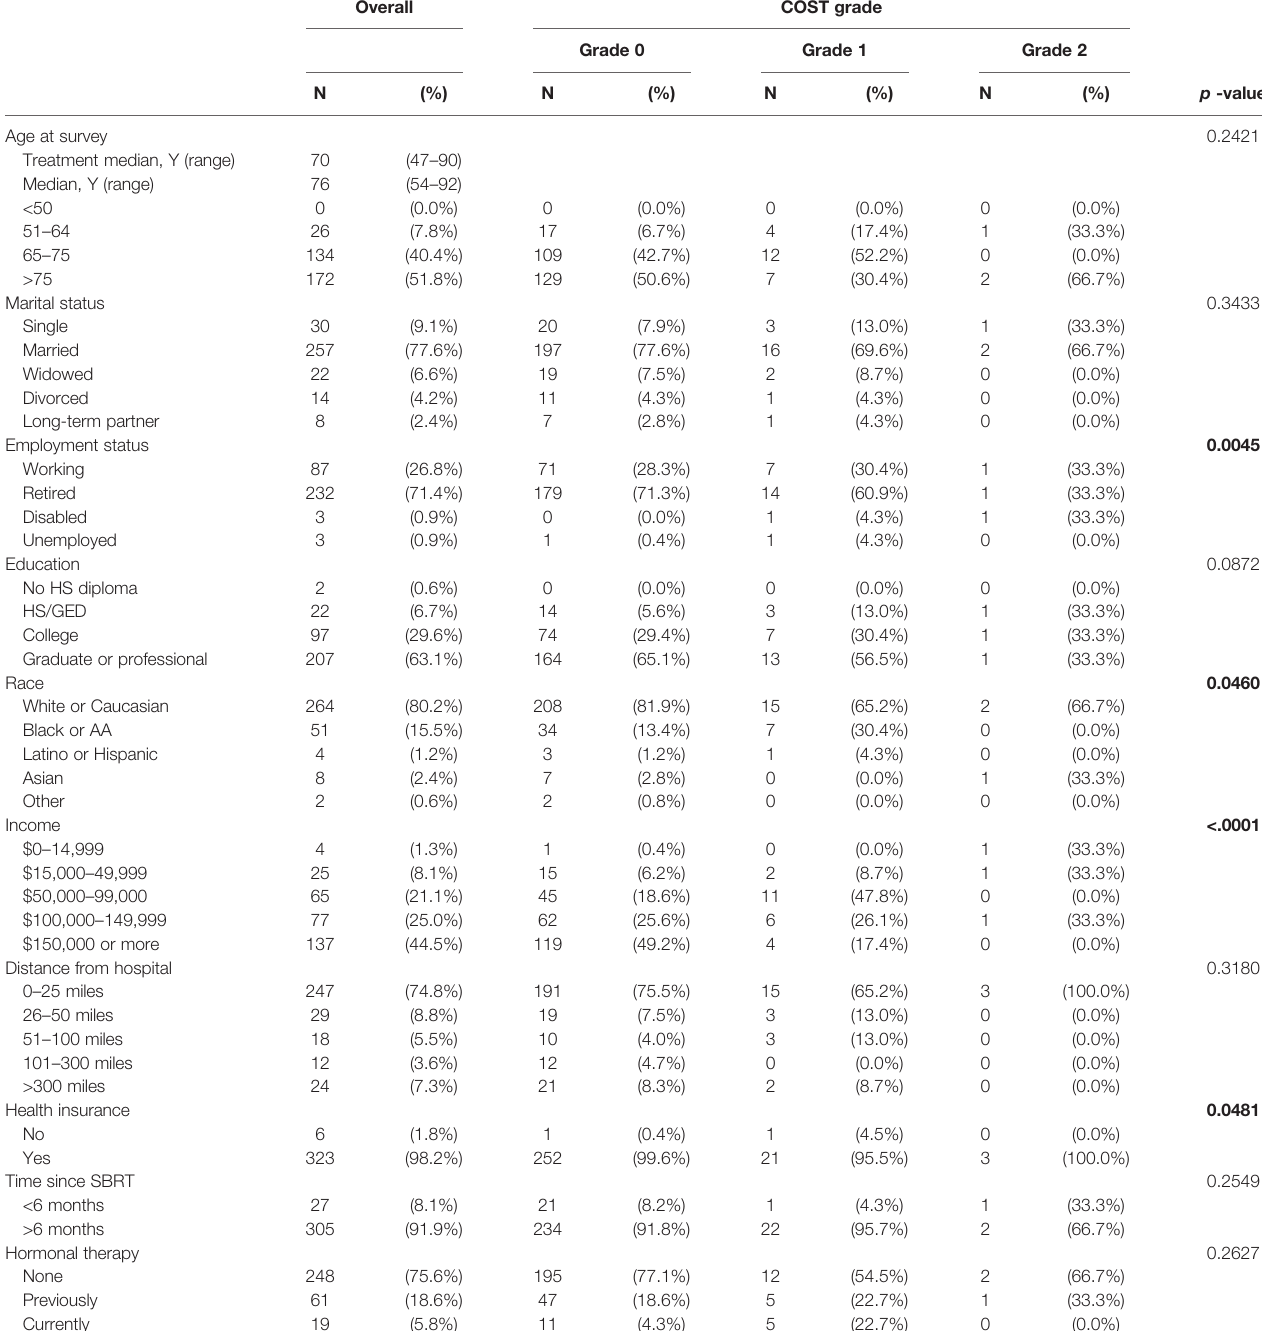
TABLE 1 | Demographics and baseline characteristics by COST toxicity